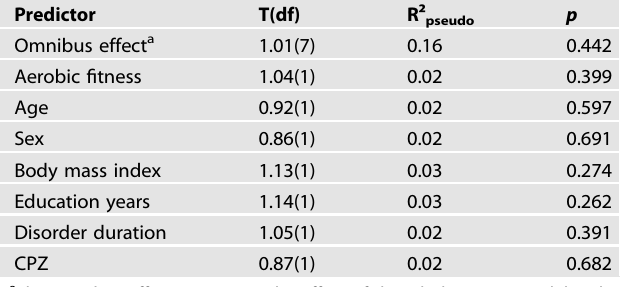
Table. 4. Results from the multivariate multiple linear regression predicting functional connectivity of seeds from the hippocampal